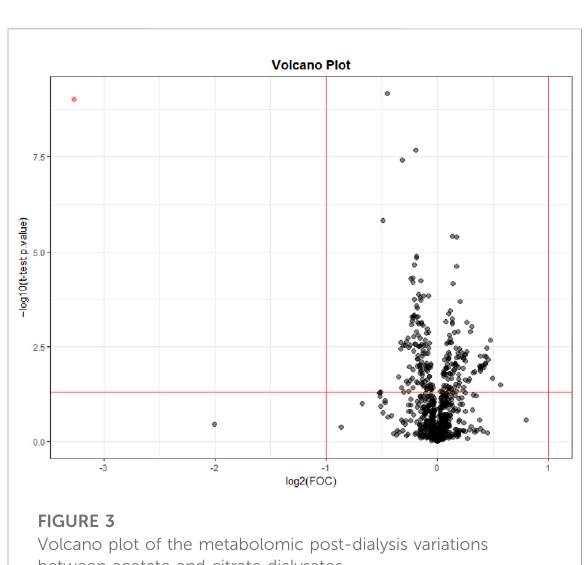
FIGURE 3 Volcano plot of the metabolomic post-dialysis variations between acetate and citrate